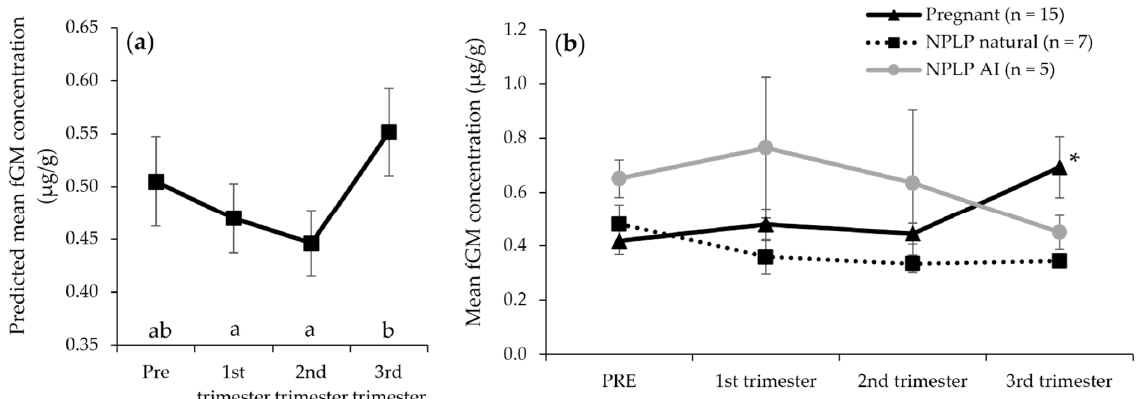
Figure 3. Predicted ( a ) and raw ( b ) fecal glucocorticoid metabolite (fGM) time period means for female cheetahs experiencing ovulatory events: pregnant, confirmed by birth of cubs, or a non- pregnant luteal phase (NPLP) following natural breeding or exogenous hormone stimulation and artificial insemination (AI), but no cubs resulted. In ( a ), all ovulatory events were combined to determine overall model-predicted means. Different lower-case letters denote differences ( p < 0.05) among time periods. Asterisk indicates a difference ( p < 0.05) from all other time periods in the pregnant condition only.